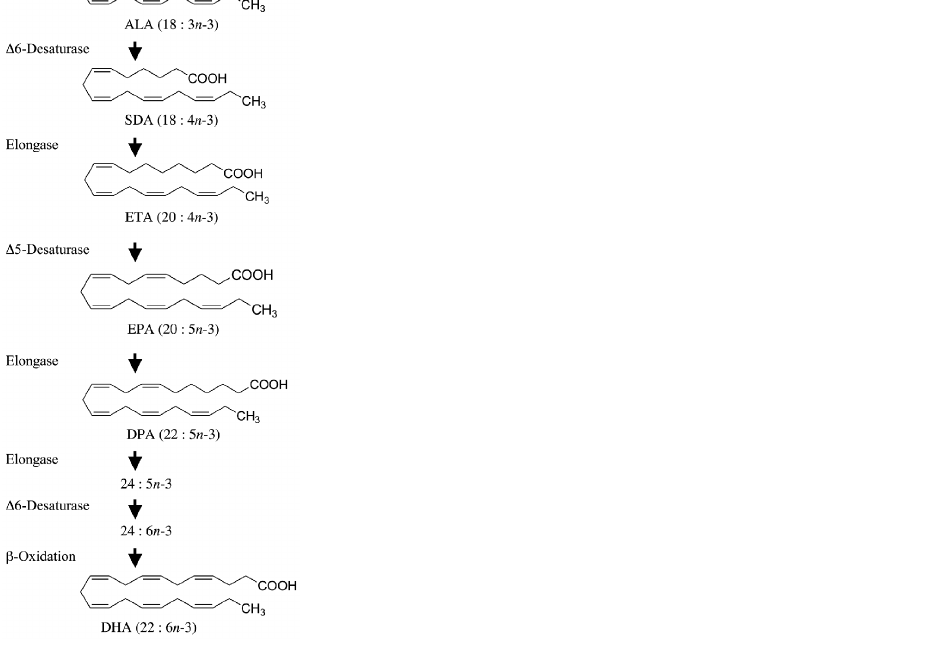
Figure 1. Alpha-linolenic acid (ALA) as a substrate of eicosapentaenoic acid (EPA) and docosahex- aenoic acid